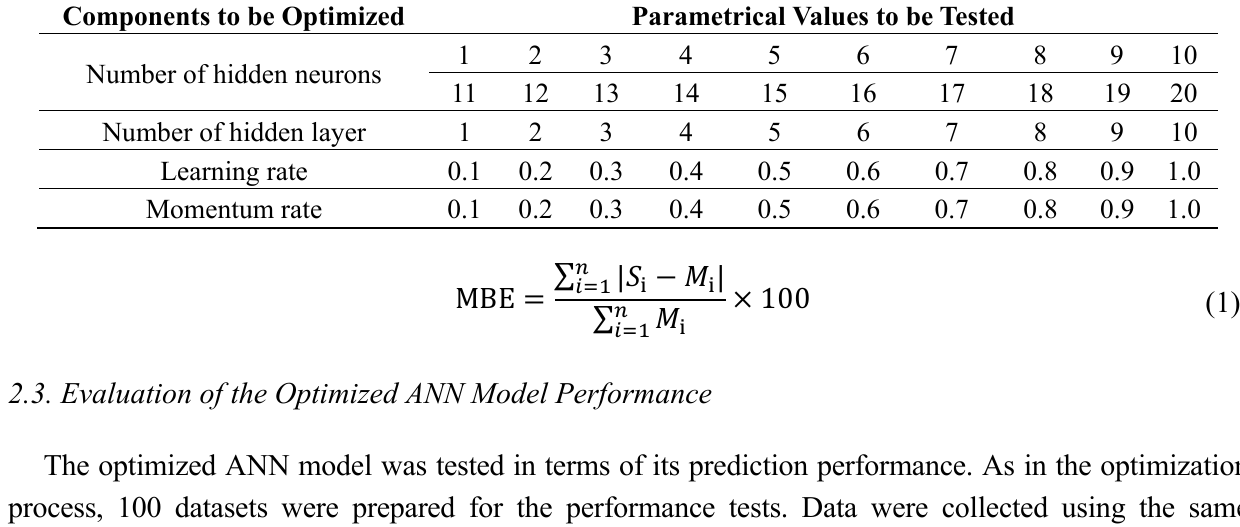
Table 6. Parametrically tested values for optimizing the ANN components. Components to be